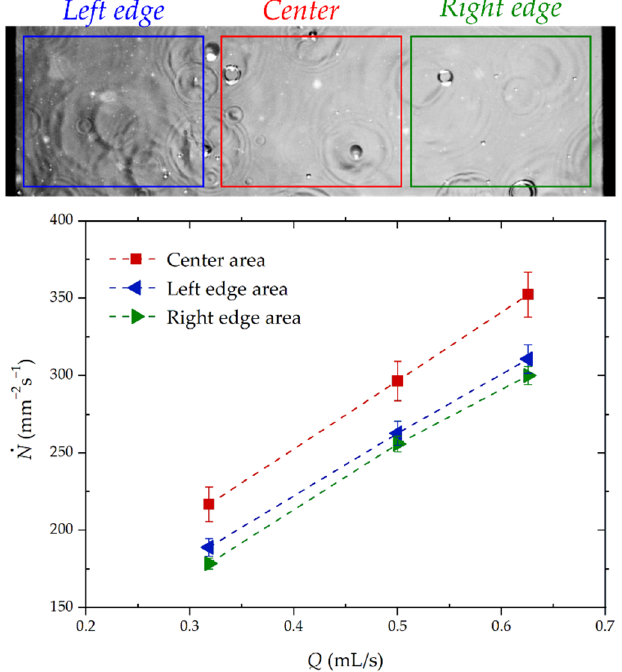
Figure 7. The dependence of the droplet flux density on the liquid flow rate for various impact surface areas.